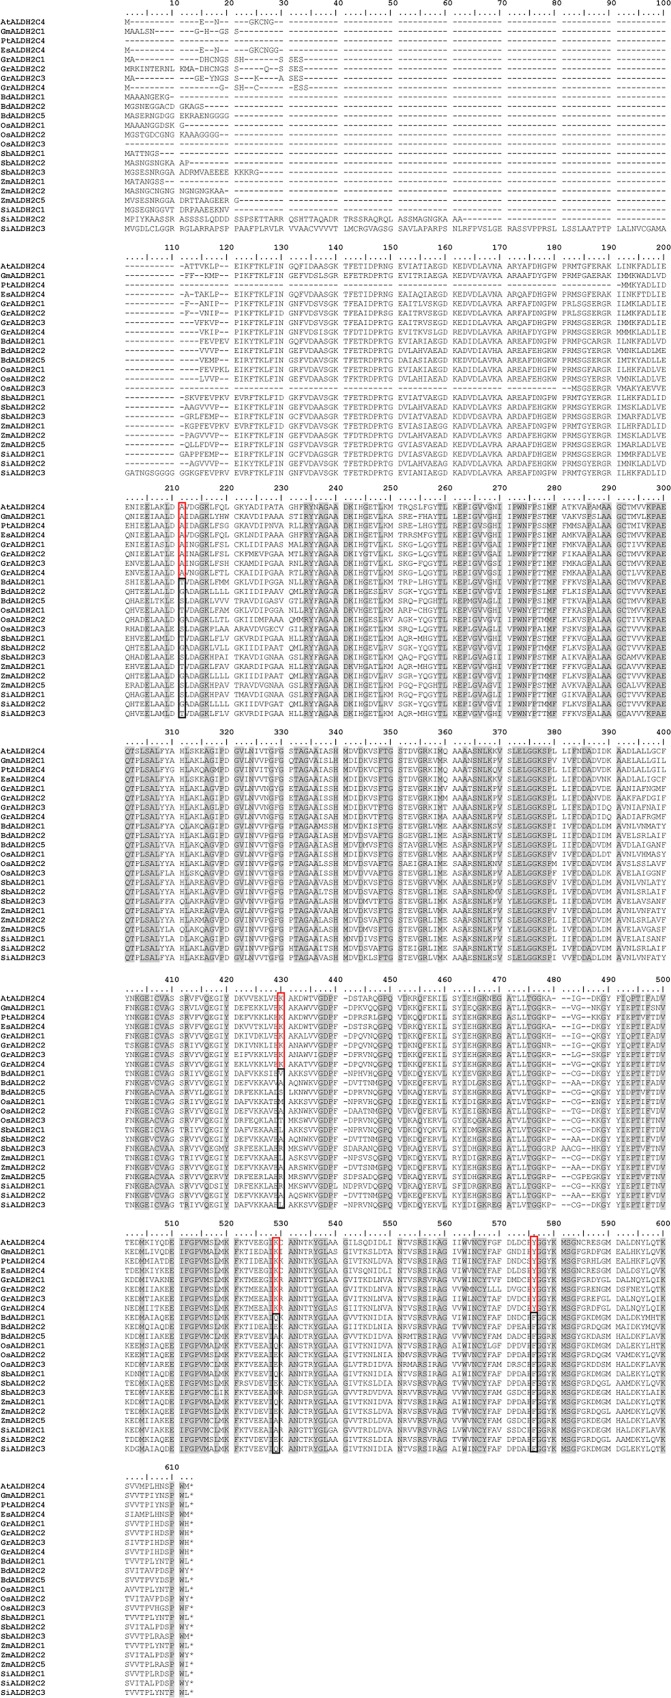
Alignment of the amino acid sequences of ALDH2C proteins.Sequences were retrieved from PHYTOZOME v10.2 and aligned by MUSCLE implemented in MEGA6. Identical residues are shown in a grey-shaded background. Sites of lineage-specific polymorphism (see text for detail) are outlined: red and black for the dicotyledonous and the monocotyledonous sequences, respectively. Prefixes were used to differentiate between genes from species: At, Arabidopsis thaliana; Gm, Glycine max; Pt, Populus tricocarpa; Es, Eutrema salsugineum; Gr, Gossypium raimondii; Bd, Brachypodium distachyon; Os, Oryza sativa; Sb, Sorghum bicolor; Zm, Zea mays; Si, Setaria italica. Asterisks (*) indicate the stop codon.